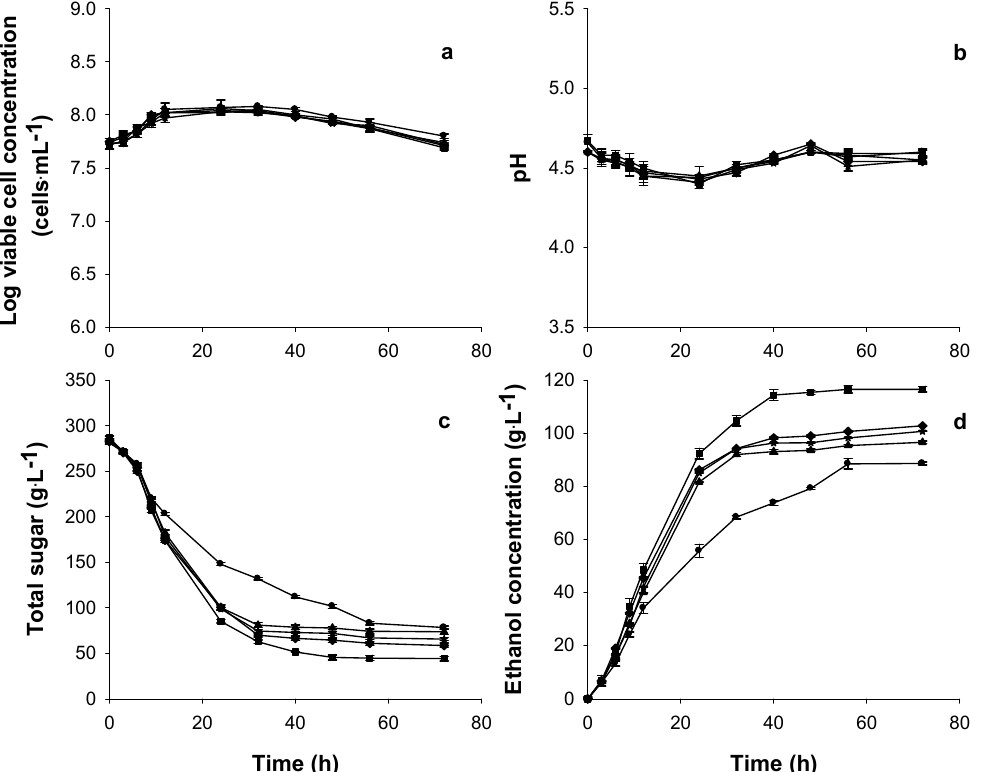
Figure 2. Fermentation parameters during single batch ethanol production from sweet sorghum juice with and without DSYH (dried spent yeast hydrolysate) or yeast extract supplementation: no supplement ( ● ), 11 ( ▲ ), 16 (  ), 21 ( ♦ ) g·L − 1 of DSYH and 9 g·L − 1 of yeast extract ( ■ ). ( a ) Log viable yeast cells, ( b ) pH, ( c ) total sugar and ( d ) ethanol